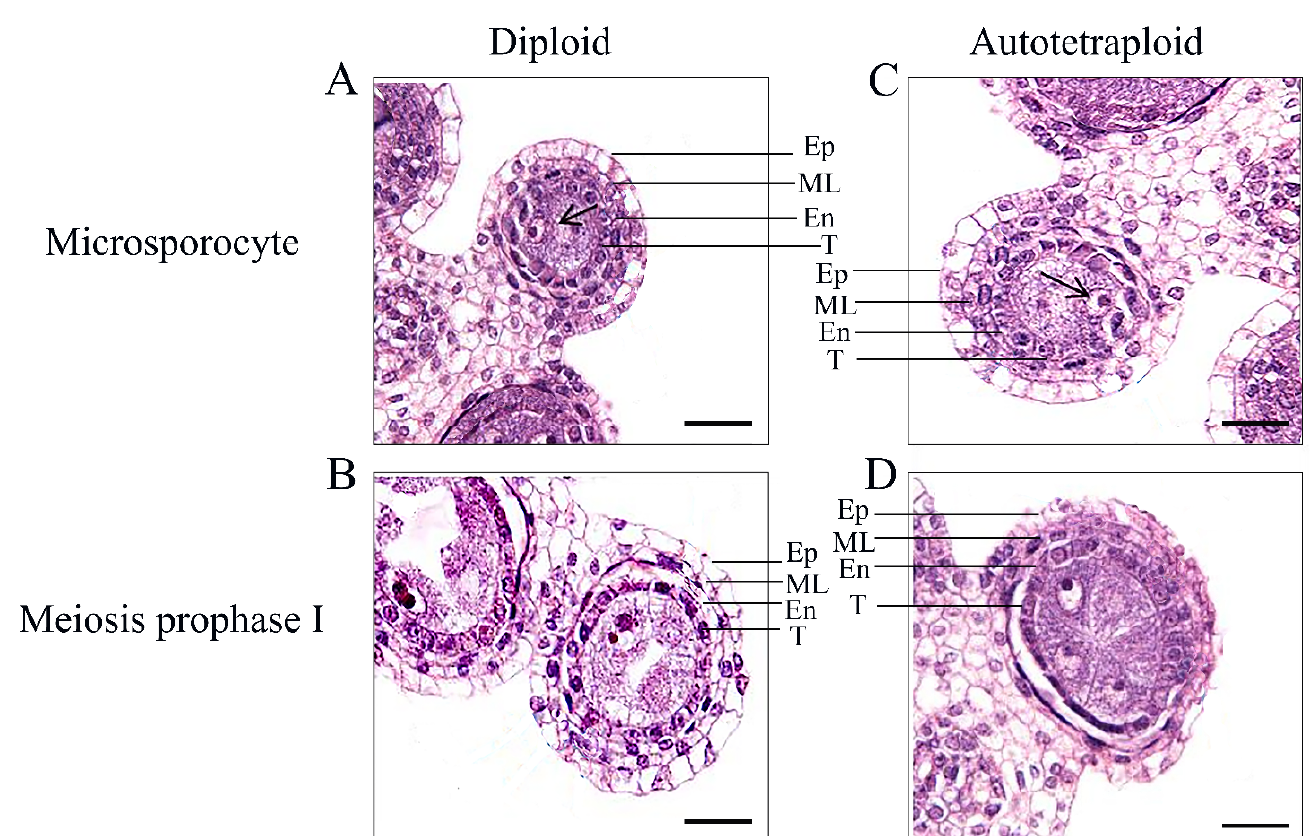
Figure 2. Observation on anther structure of diploid rice and autotetraploid rice. ( A , B ) Diploid; ( C , D ) autotetraploid, gradual degradation of tapetum in prophase I of meiosis. Note: Ep = epidermis layer; ML = middle layer; En = endothelium layer; T = tapetum layer. Bar = 100 μm.